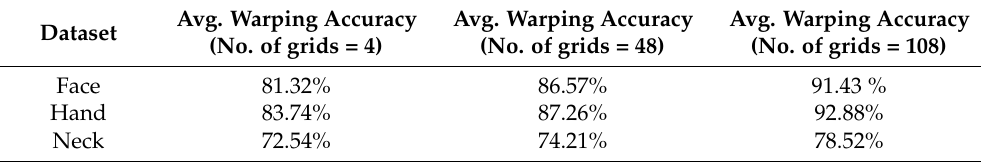
Table 1. Average accuracy of ROI